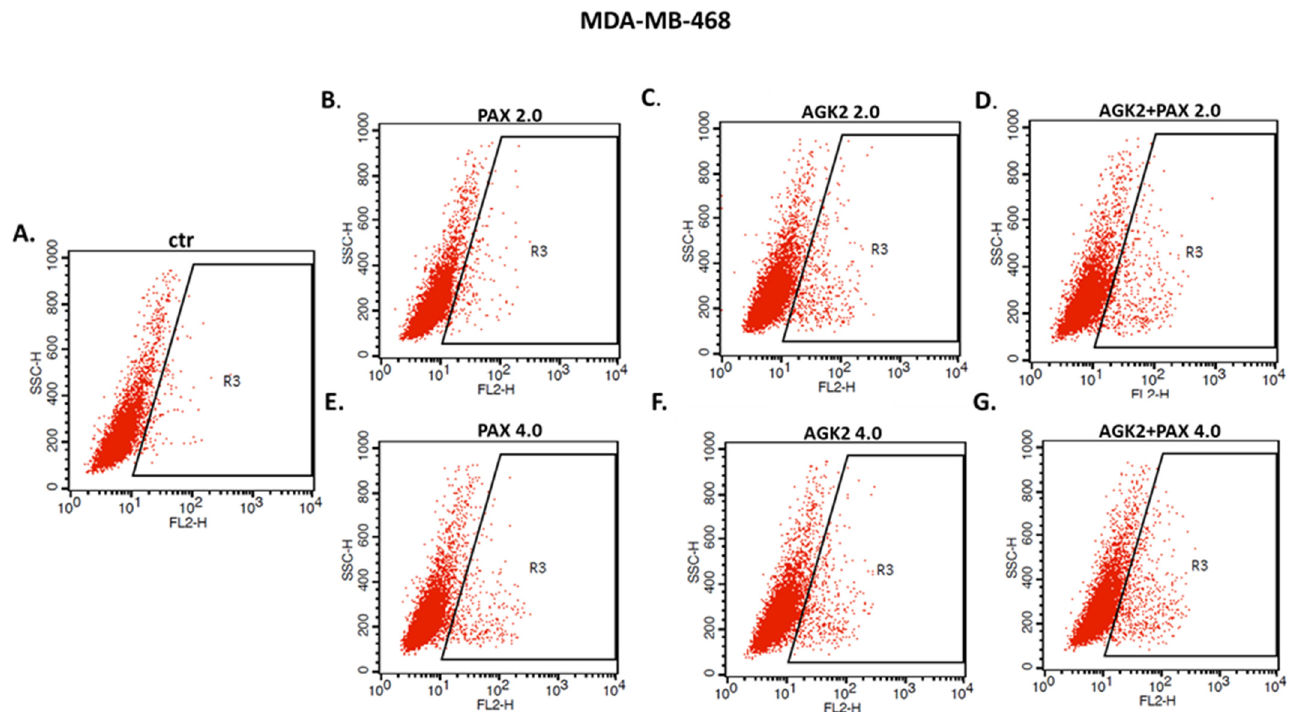
Figure 16. Representative dot plots from the FACS of the MDA-MB-468 TNBC cells after a 48 h incubation with a medium (ctr) ( A ), paclitaxel (PAX) ( B , E ), AGK2 ( C , F ) and PAX + AGK2 ( D , G ) (2.0 = IC 50 + IC 50 , 4.0 = 2IC 50 + 2IC 50 ). R3—apoptotic cells with active caspase-3.